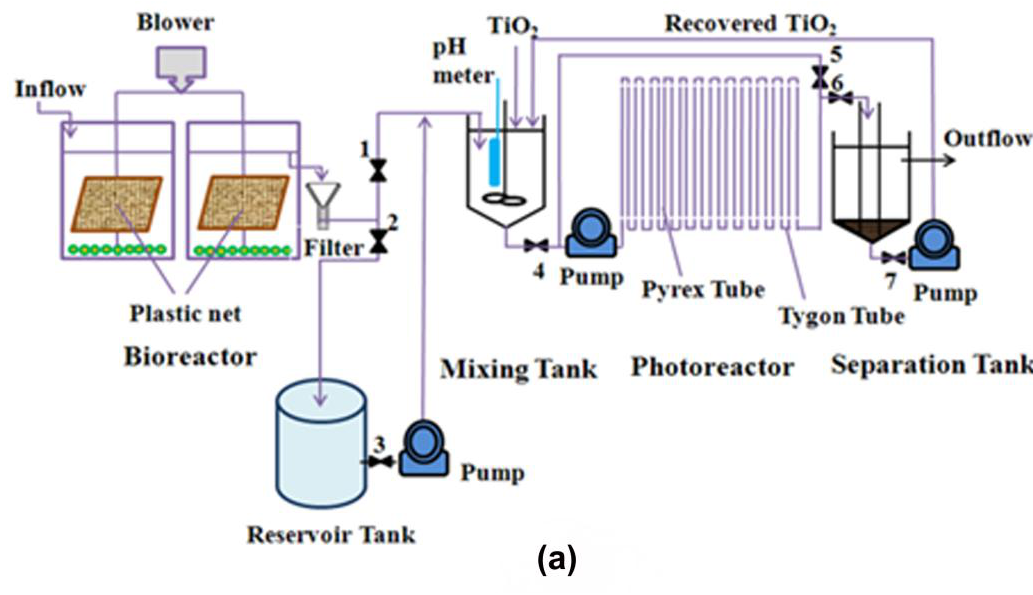
Figure 7. Schematic of the coupling of ( a ) biological [140] and ( b ) wetland treatment technologies [145] with